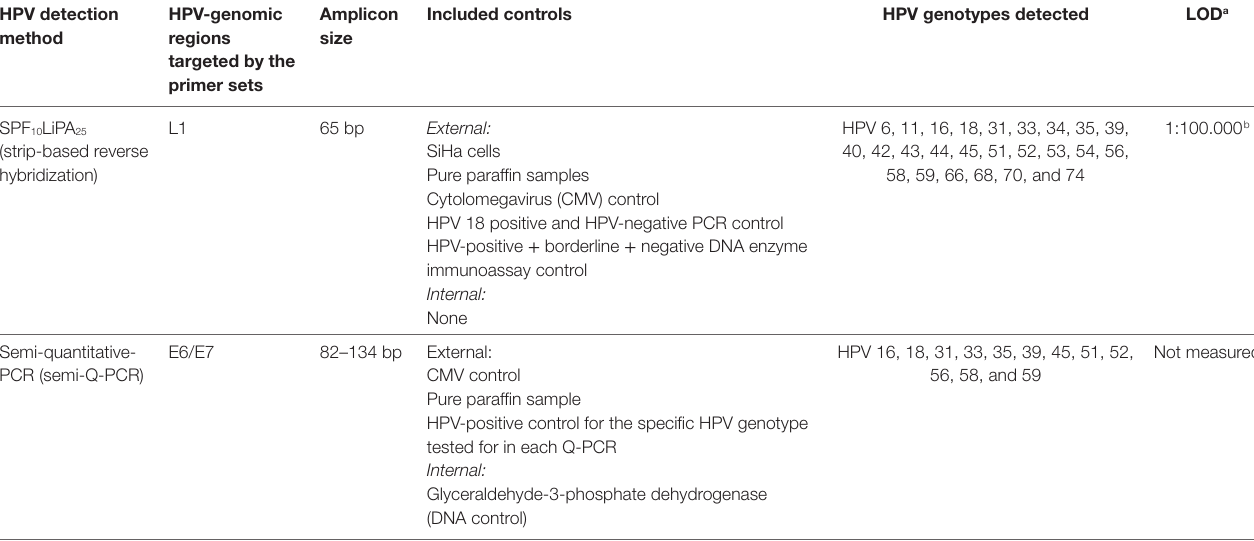
TaBle 2 | Characteristics of the PCR-based human papillomavirus (HPV)